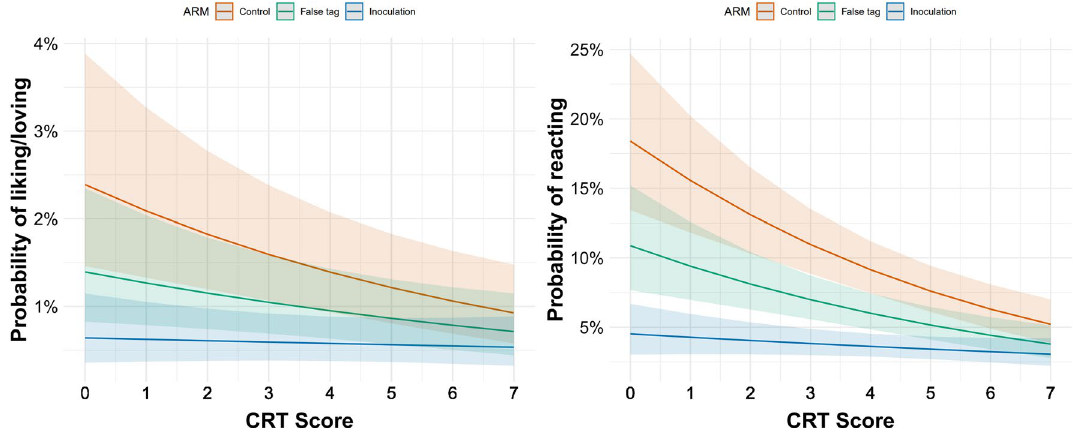
Figure 4. Predicted probably of engaging with misinformation by CRT score and arm. The probability of ‘liking’/loving’ or ‘reacting’ to misinformation posts did not change for participants who received the inoculation intervention, regardless of their CRT score.